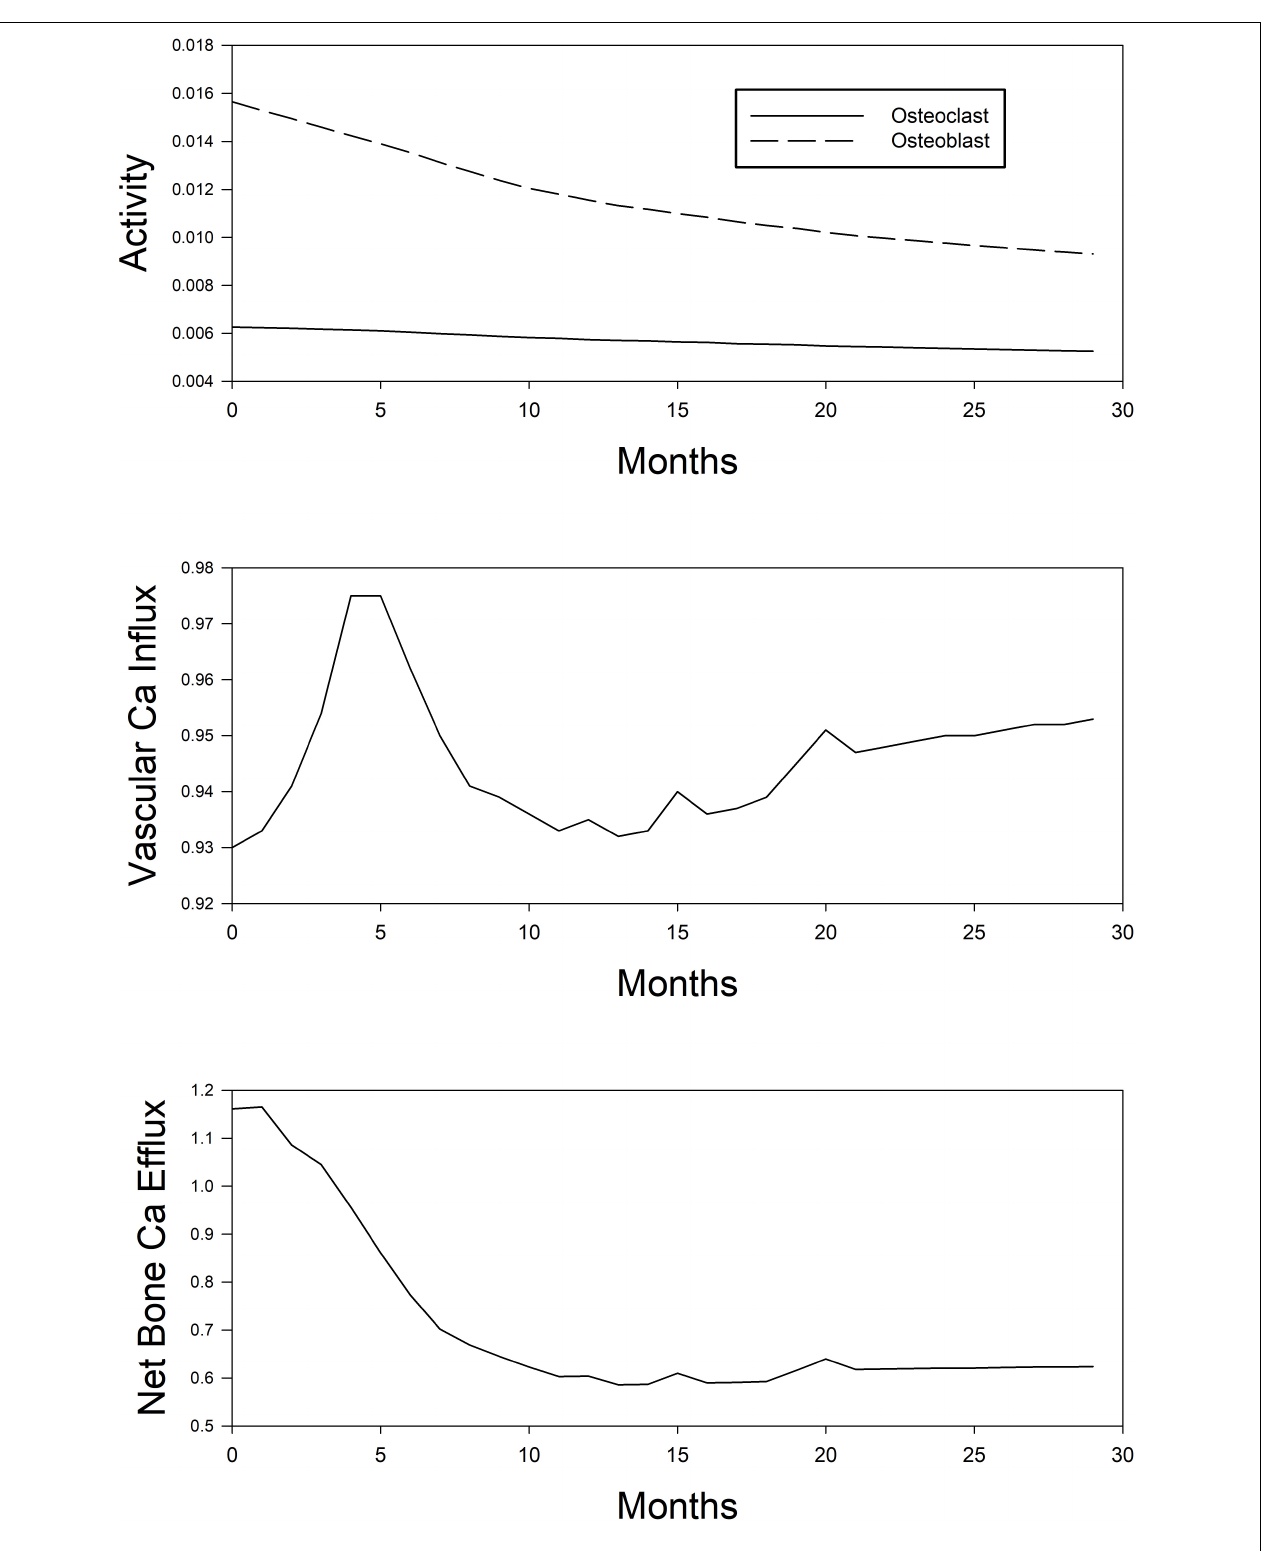
FIGURE 4 | Simplified depiction of the predicted time course of model-estimated (unobservable) parameters of mineral metabolism in the simulated ( in silico ) treatment of CKD-MBD using phosphate binder, vitamin D analog, and a calcimimetic. Top panel, osteoblast (dashed line) and osteoclast (continuous line) activity. Middle panel, Ca influx into the vascular smooth muscle cell tissue. Bottom panel, net Ca efflux out of the bone compartment.